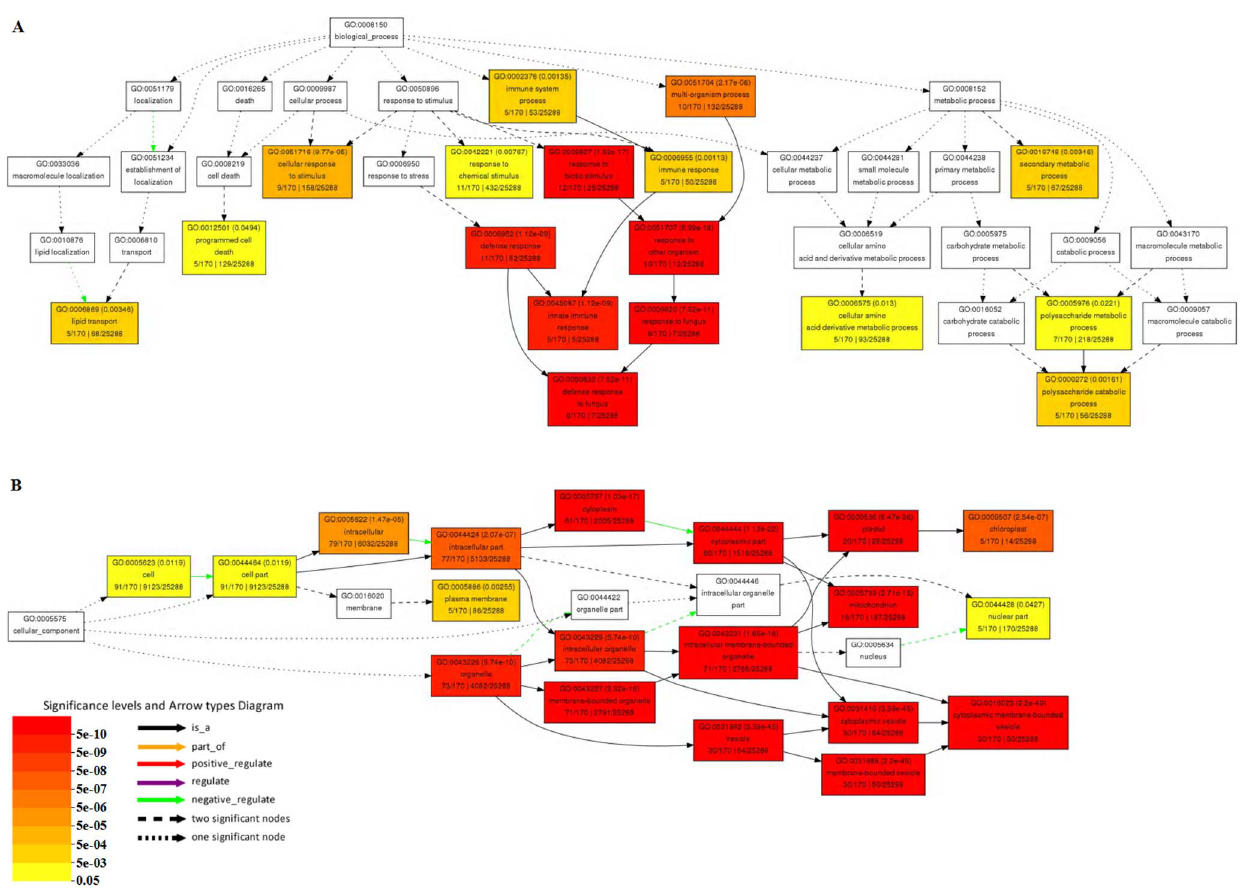
Figure 3. GO clustering of up-regulated DEGs. ( A ) GO enrichment analysis according to GO catalogue (GO:0008150 biological process). ( B ) GO enrichment analysis according to GO catalogue (GO:0005575 cellular component).